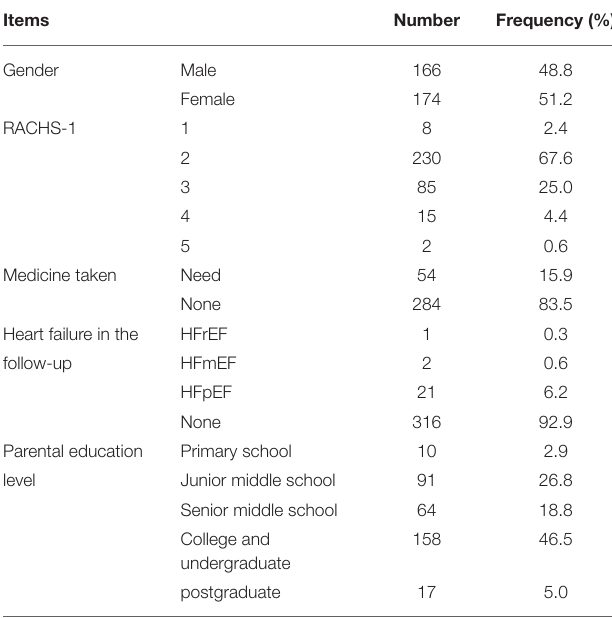
TABLE 3 | Fit of different score